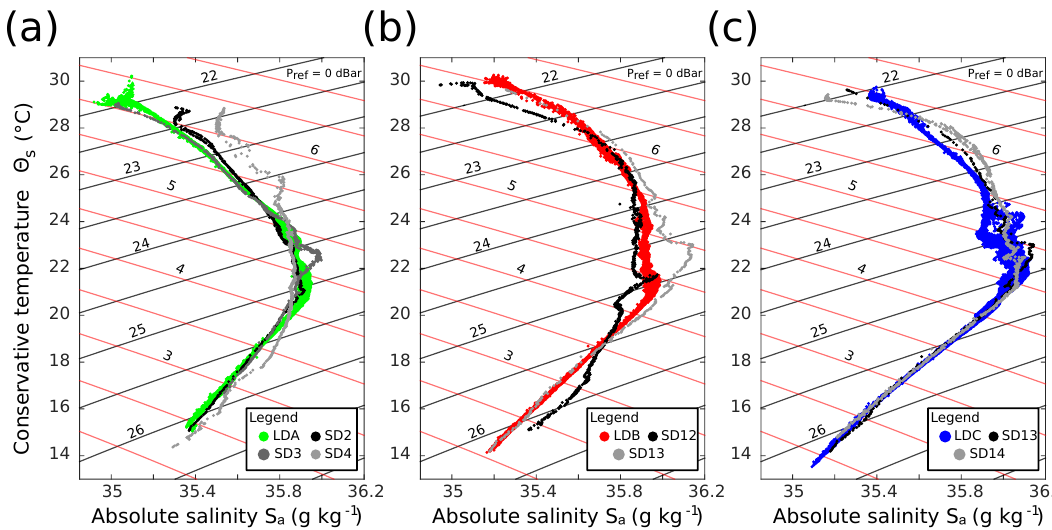
Figure 4. T - S diagrams of (a) LDA, (b) LDB, and (c) LDC and surrounding stations. LD stations are color coded, and SD stations different shades of gray. Isopycnals are displayed in black, with isopleths of spice shown in red.